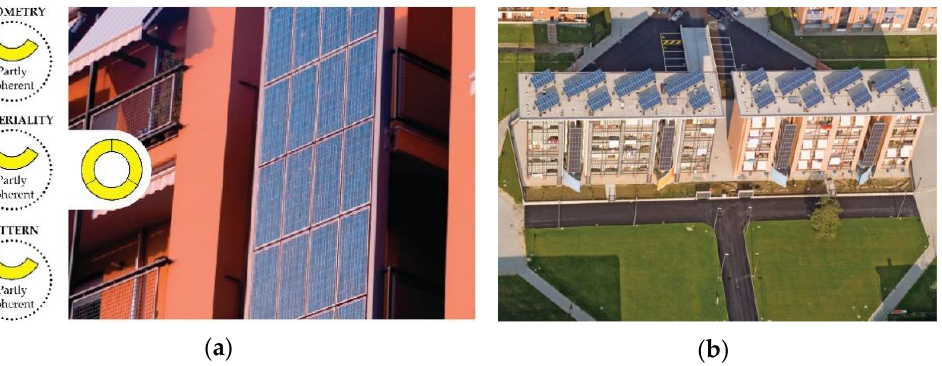
Figure 6. Architectural integration matrix for the PV systems in the Photovoltaic Village of Alessan- dria (left); ( a ) PV panels installed on facade in front of the stairways (source: © PierFranco Robotti); ( b ) aerial view of the systems installed on the flat roofs (Source: © Municipality of Alessandria).